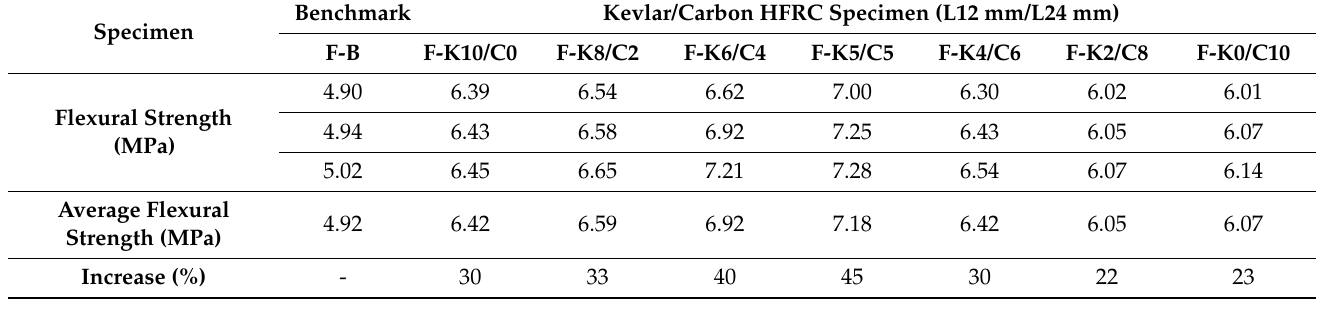
Table 7. Flexural strength of benchmark and Kevlar/carbon HFRC specimens.